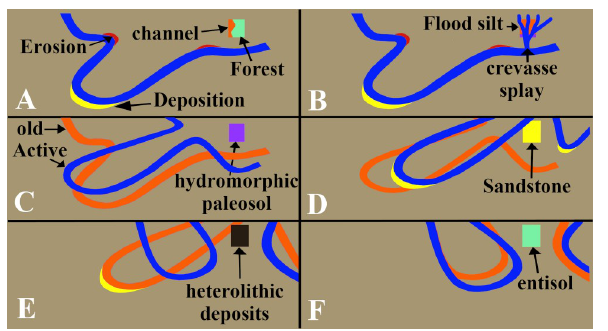
Fig 10. Interpretation of deposits associated with the lateral migration of a local channel. TCHD is represented as a rectangular box. The position and possible direction of the lateral migration of the channel is based on extrapolations of the field observation at TCHD. The variations in sedimentary deposits, their thickening and thinning were used to extrapolate possible changes beyond TCHD. (A) A local depression along an abandoned channel that pooled seasonally at a distal part of a floodplain. The environment was stable for long enough time that allowed the establishment of the multi-general forests. (B) A crevasse splay changed the environment from a seasonal pool to a permanent wetland. The forest didn’t survive the change in the depositional environment. (C) The accretion of the clay and silt changed the local landscape which resulted in lateral migration of the local channel. (D) The channel scoured the deposits in the local depression and carved a new channel. (E) Shale deposited on the distal part of the active channel (F) Another lateral change made the bank of the active channel stable as was evident from the development of a paleosol.